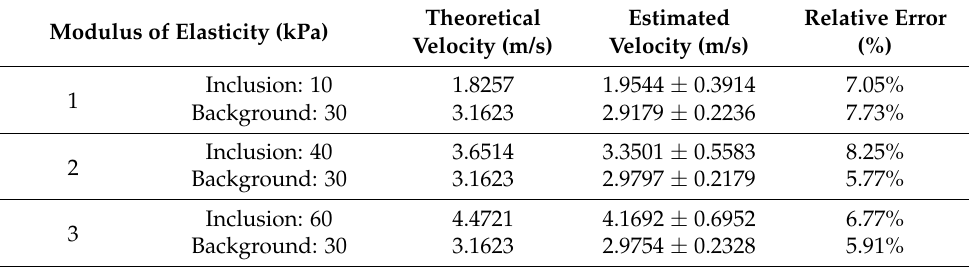
Table 3. Comparison of shear wave velocity estimation. Analysis of velocity image reconstruction in the intercepted area and the background area with the real-time curve tracing